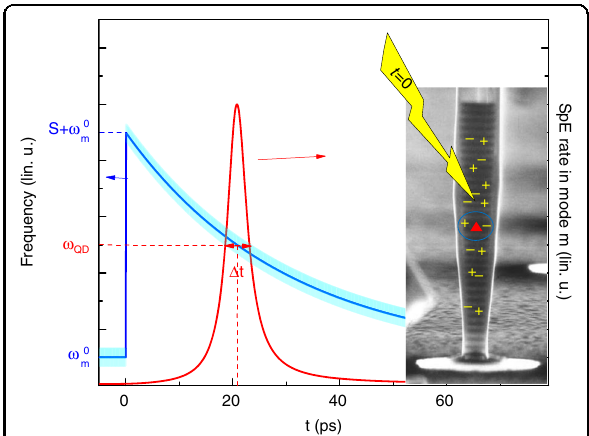
Fig. 4 Sketch of principle of a Purcell switching experiment for a single QD in a pillar microcavity. (Right) The electron micrograph shows a typical QDM used in this work; here the pillar diameter is 1 µm. At t = 0, a laser pulse generates free charge carriers, which both excite the QD and induce a modi fi cation of the refractive index of GaAs, hence a frequency shift S of the cavity mode. (Left) Temporal dependence of the mode frequency ω m (blue line, broadened by the mode linewidth Δω m ). The QD emission frequency ω QD belongs to ; ω 0 þ S ] that is swept by the mode during the frequency interval [ ω 0 m m its relaxation. For the chosen parameters (35 ps relaxation time, ħ S = = 2 meV), resonant coupling between mode m 4 meV, (cid:1) h ω QD (cid:2) (cid:1) h ω 0 m and the QD occurs around 20 ps. Thanks to the Purcell effect, a few ps long SpE pulse is emitted into the cavity mode. The pulse intensity, shown by the red curve, is calculated using a rate equation model 25